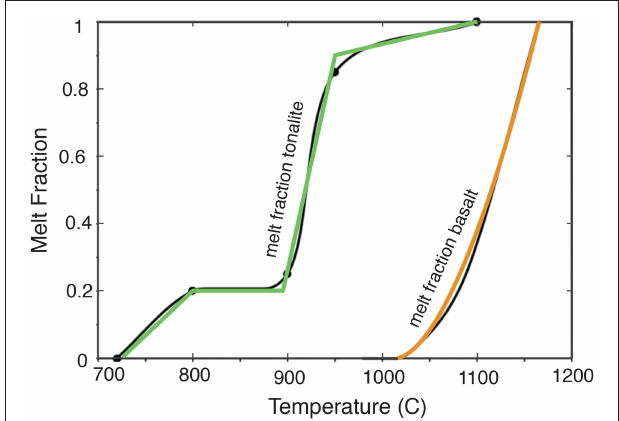
FIGURE 4 | Melt fraction vs. temperature curves for basalt and tonalitic rocks. Black curves are reproduced from Petcovic and Dufek (2005), while colored curves are fits used for thermal modeling in this